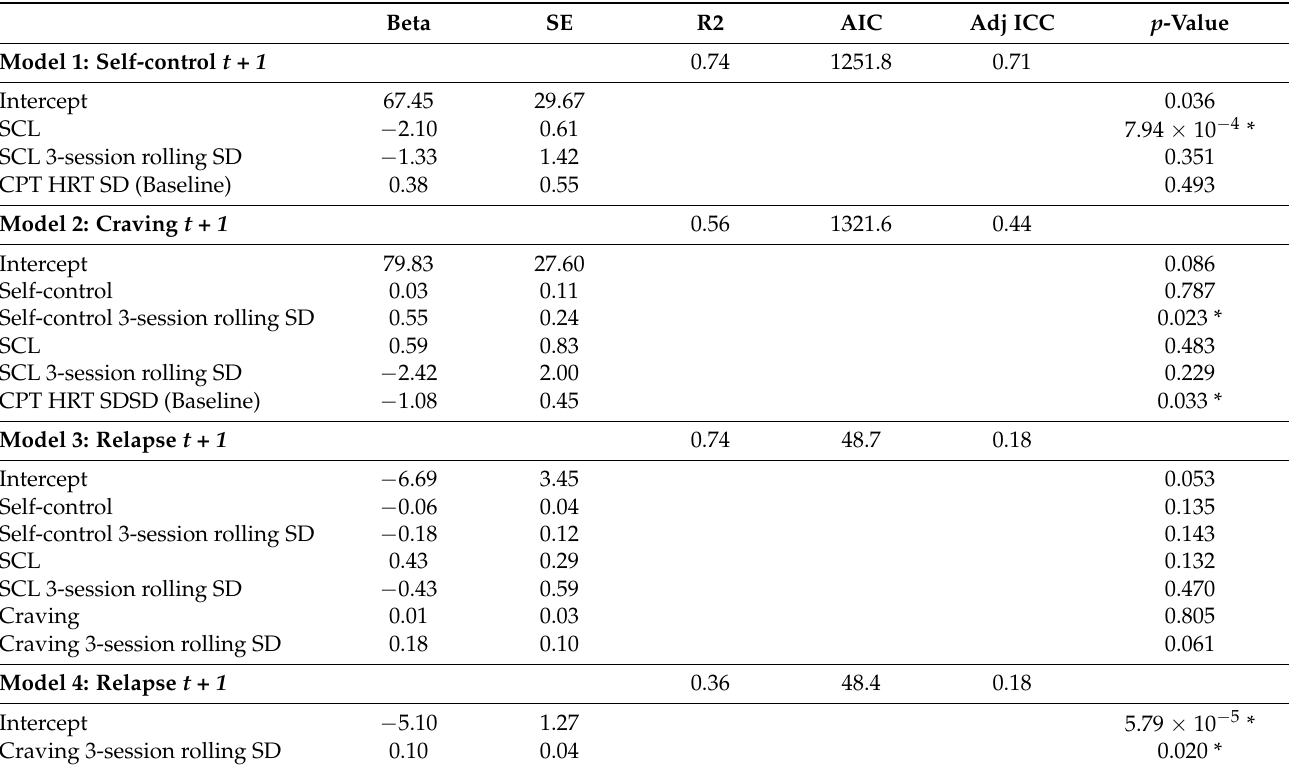
Table 3. The mixed effects models (LMM and GLMM) with observations nested within subjects. SCL: Hopkins Symptom Check-list 5 item version, CPT HRT SD: Conners Continuous performance